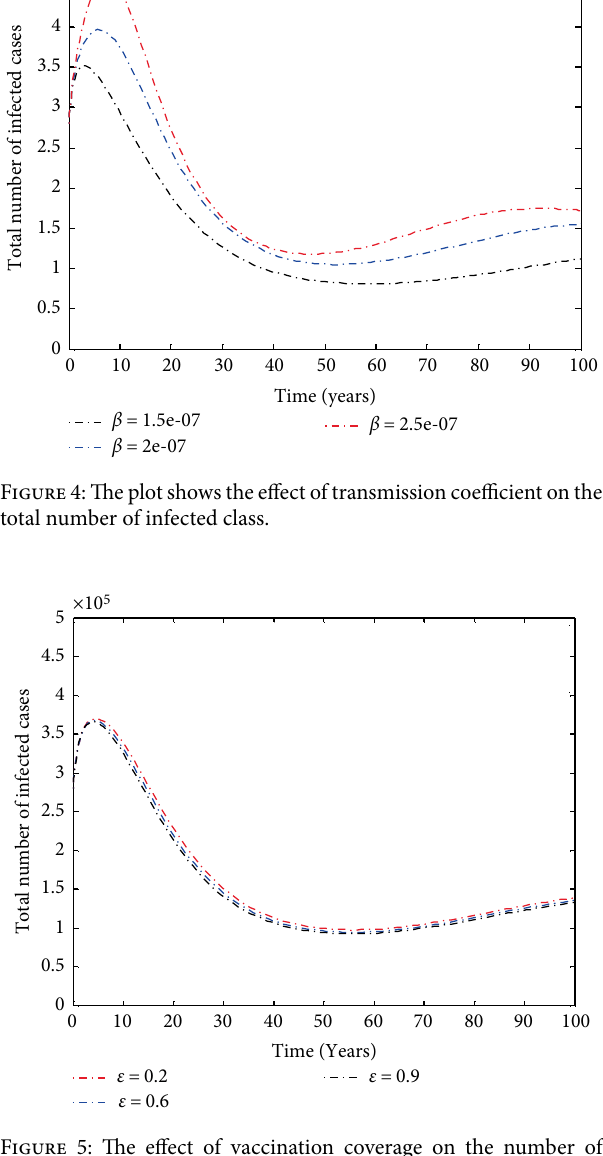
Figure 7: The effect of treatment coverage on the number of infected